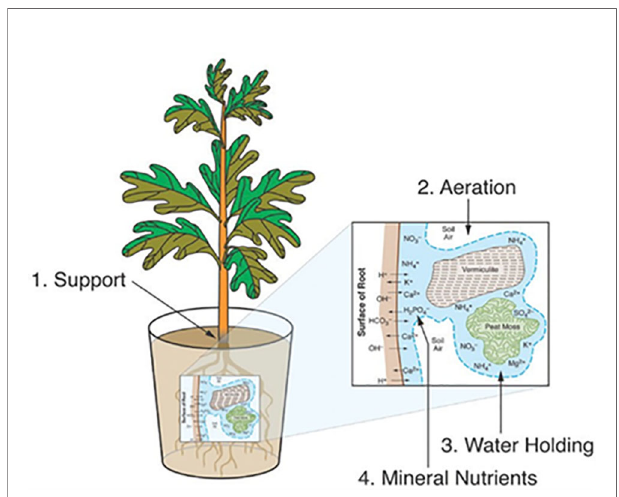
FIGURE 1 | Relationship between biomass produced and amount of solar radiation intercepted by rapeseed crops between sowing and fl owering (open symbols) and between fl owering and harvest (closed symbols). Different symbols denote different cultivars and numbers next to each symbol indicate order of sowing. Lines drawn indicate RUE 1.0 and 1.5 gMI -1 . (Adopted from: Mendham et al.,